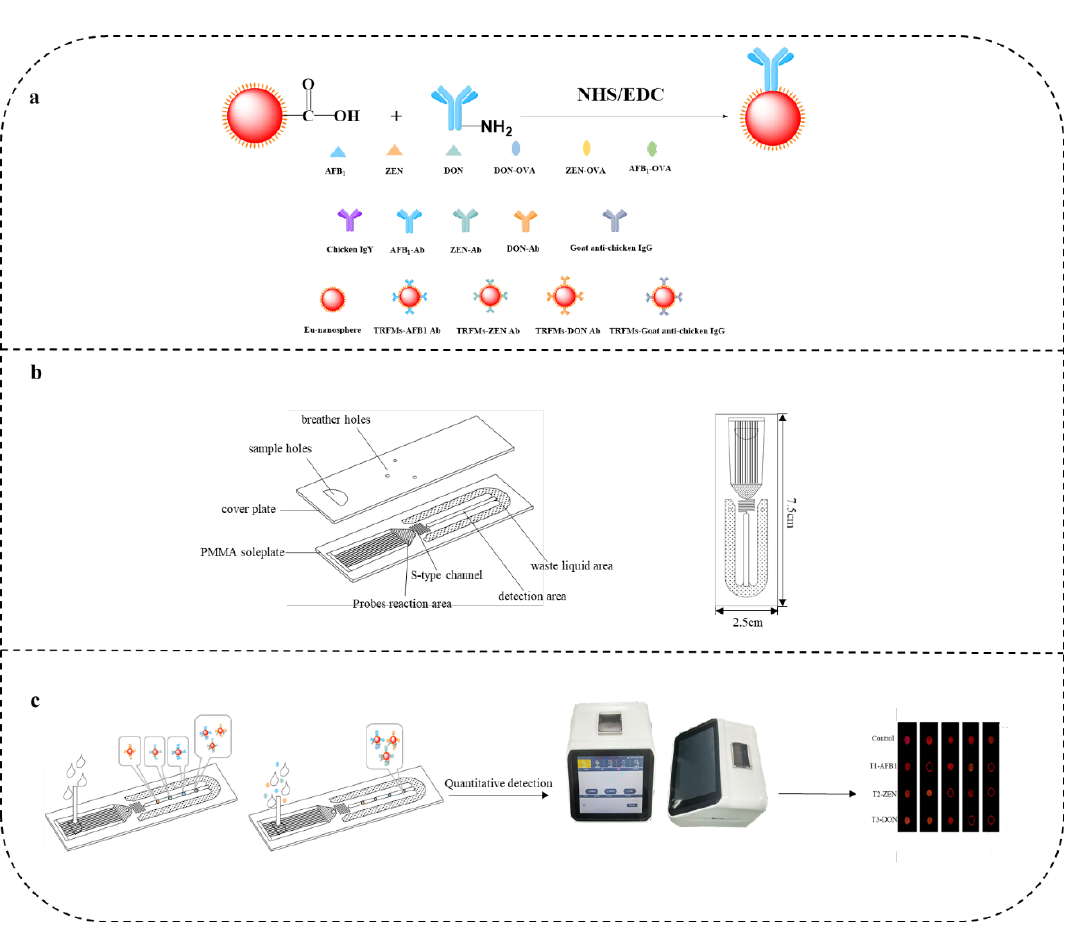
Figure 3. ( a ) Isotype determination of MAb; ( b ) The electropherogram of Mab.